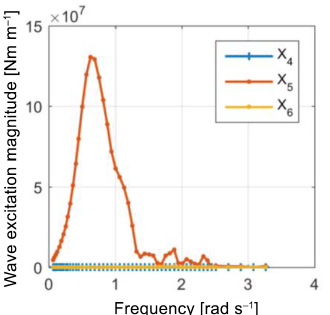
Figure 13. Wave excitation magnitudes for roll ( X 4 ), pitch ( X 5 ) and yaw ( X 6 ) degree of freedom for the considered platform and considered direction (Yu et al.,